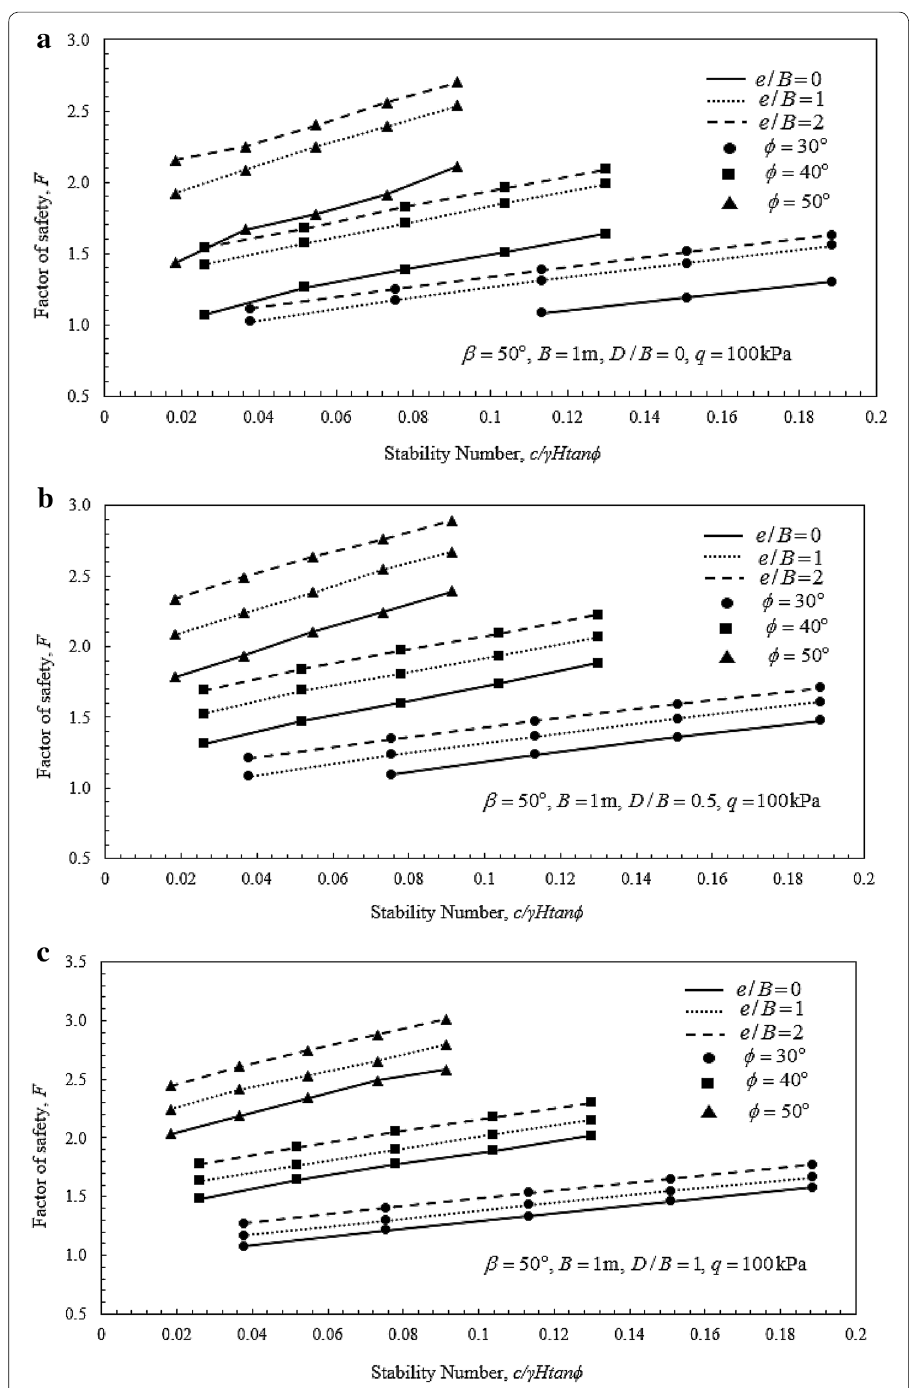
Fig. 15 Design Charts for β = 50 ◦ : a D / B = 0 , b D / B = 0.5 , c D / B =